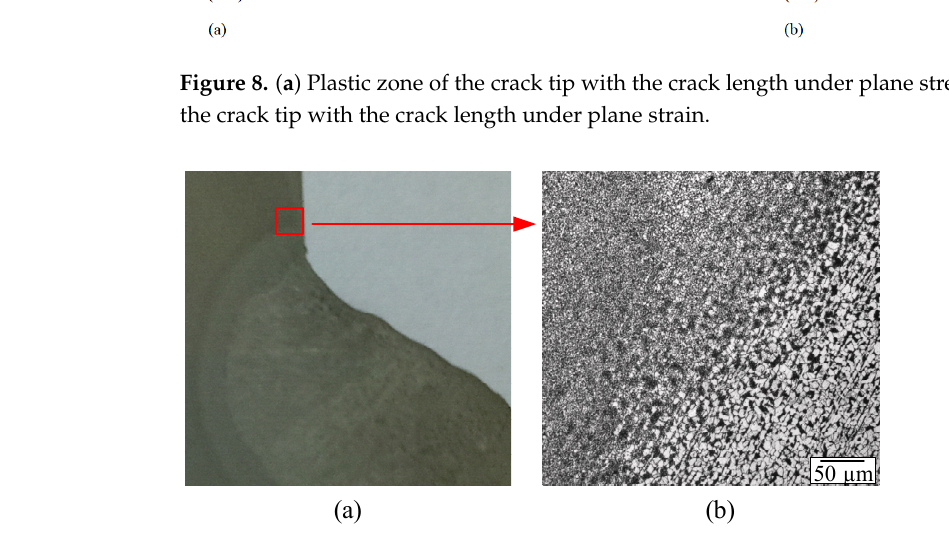
Figure 9. ( a ) Local grain gradient position of weld toe. ( b ) Metallography of grain gradient.